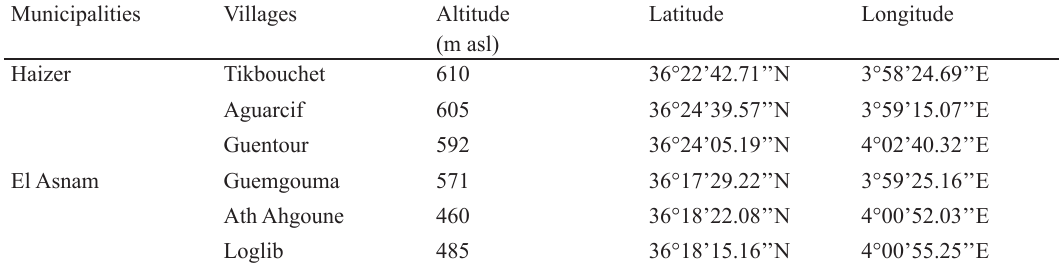
Table 1. Geographic coordinates of the study villages. Datum WGS84. Municipalities Villages Altitude